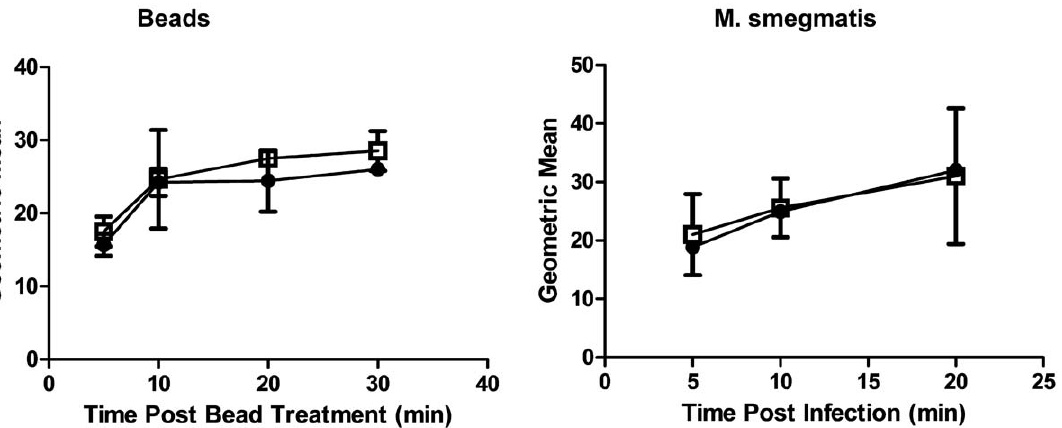
Figure 1. Knockdown of PI3K p110 a does not impair phagocytosis of prey less than 3 m m in diameter. Cells were either fed Alexafluor 633-SE labelled BSA-coupled 3 m m magnetic beads or infected with Alexafluor 633-SE labelled M. smegmatis. Flow cytometric analysis was done to determine uptake. Solid circles = control cells, empty squares = p110 a knockdown cells. Data are means + / 2 s.e.m., from three independent experiments. No significant differences were